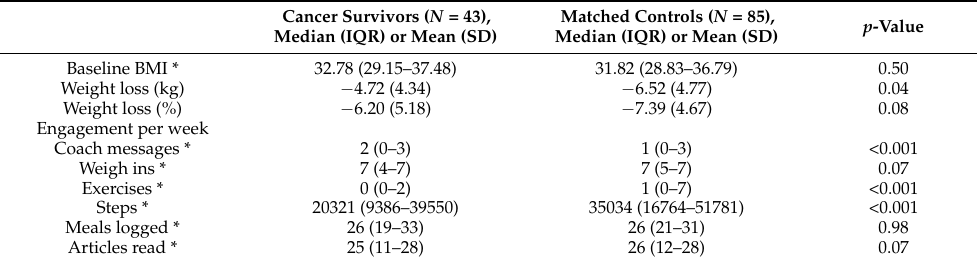
Table 2. Weight and engagement for cancer survivors and matched